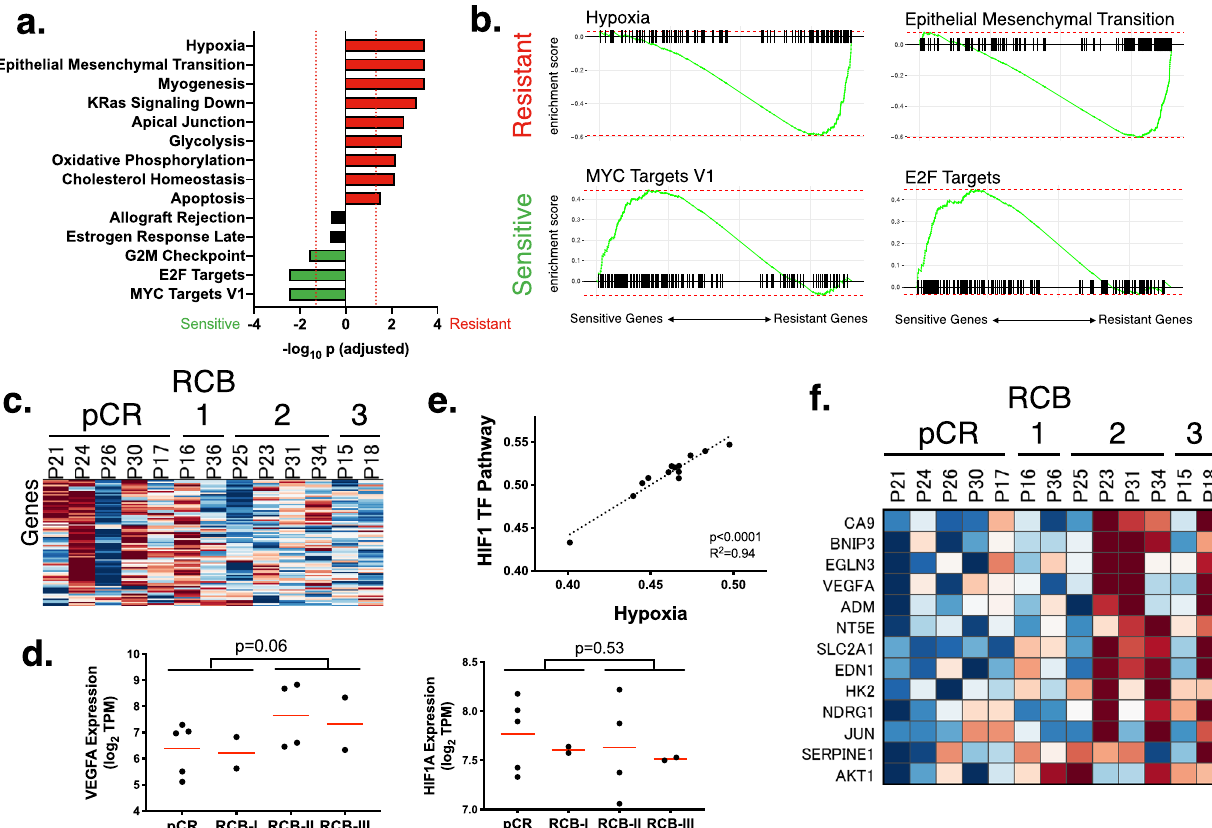
Fig. 3 Pathways correlated with resistance. a This shows the association between Hallmarks pathways and response to talazoparib. Each bar stands for a pathway, and the height indicates the statistical signi fi cance as the -log 10 of the adjusted p -value. The pathways that are associated with sensitivity to treatment are shown in green and those associated with resistance are red. b This contains the GSEA enrichment plots for pathways most strongly associated with resistance to talazoparib. Pathways that are higher in resistant tumors are in the top row, and the bottom contains the pathways higher in sensitive tumors. The genes are ranked such that the ones associated with sensitivity are on the left, and those with resistance are on the right. c This heatmap shows the expression of the most differentially regulated genes (leading edge) of the MYC Targets V1 pathway (rows) for each of the tumors (columns), organized by response. Warmer colors indicate higher expression, and cooler colors are lower expression. d These plots show the association of the expression of VEGFA (left) and HIF1A (right) with response. The mean expression is shown as a red line. p -values (unpaired two-sided Student ’ s t tests) are shown after comparing patients with no progression (pCR and RCB-I) against those that progressed (RCB-II and RCB-III). e This plot compares the scores of the hypoxia pathway ( x -axis) against that with a HIF1 transcriptional network ( y -axis). The p -value is calculated from a two-sided Pearson ’ s correlation coef fi cient test. f This heatmap shows the expression of the genes in the leading edge of the hypoxia pathway. The heatmap is arranged as in panel c